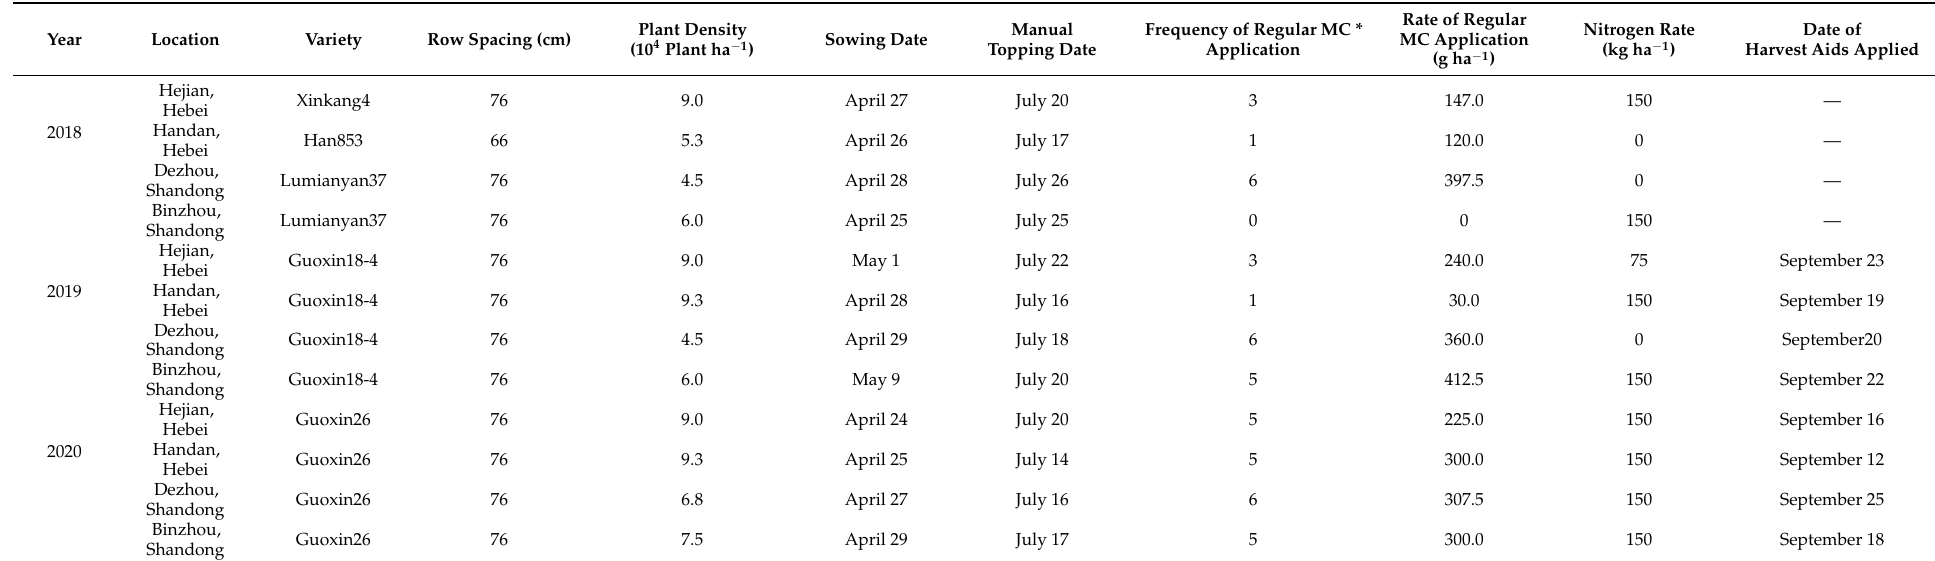
Table 1. Major agronomic practices for cotton production in the study